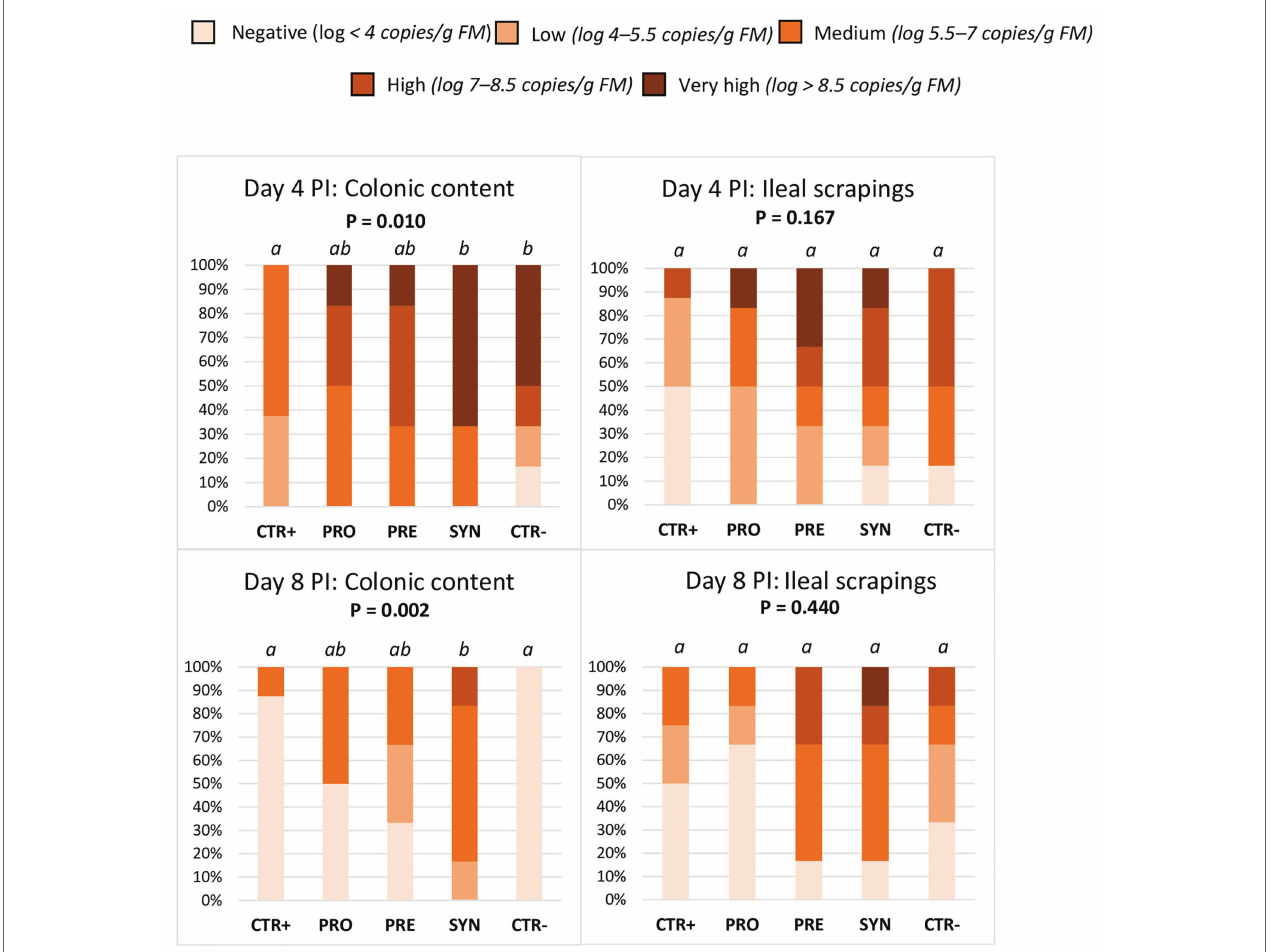
FIGURE 4 | Effect of experimental treatments on the percentage of animals with different levels of ETEC F4 counts in colonic digesta and ileal scrapings on days 4 and 8 post-inoculation (PI). Different animals were sampled on day 4 PI and 8 PI. CTR+: non-inoculated animals receiving placebo; PRO − : inoculated animals receiving the probiotics; PRE: inoculated animals receiving the prebiotic; SYN: inoculated animals receiving the synbiotic; CTR − : inoculated animals receiving placebo. N = 6 for all groups except for non-challenged animals ( N = 8). Values of p were obtained using Fisher’s exact test in R software. a and b indicate statistically significant differences between groups. FM, fresh matter; PI,